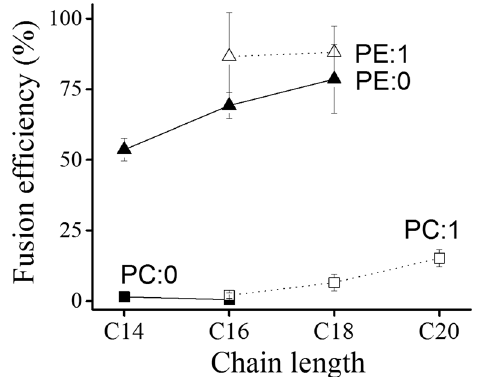
Figure 7. Liposomal fusion efficiency vs. neutral lipid component. Fusion efficiency of liposomes containing a neutral lipid component with different chain lengths and chain saturations as well as DOTAP and BODIPY FL-DHPE (1/1/0.1 mol/mol) was determined on CHO cells by flow cytometry. Symbols: saturated chains—filled symbols, unsaturated chains—open symbols, PCs—squares, PEs—triangles.